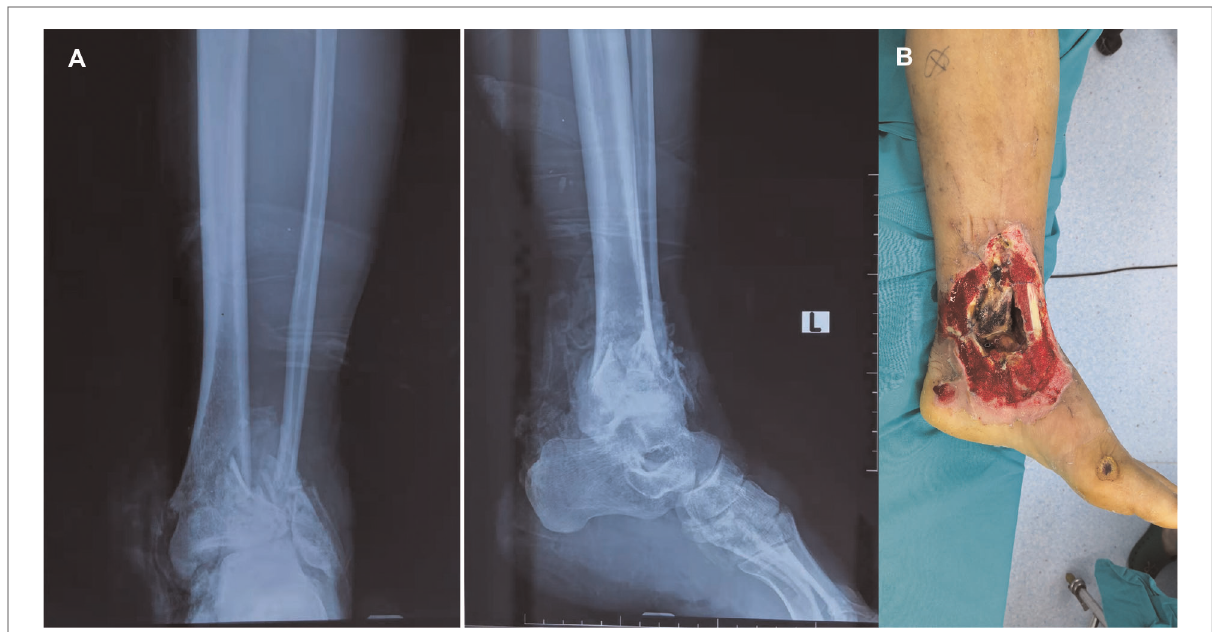
shows sign of infection and necrosis.